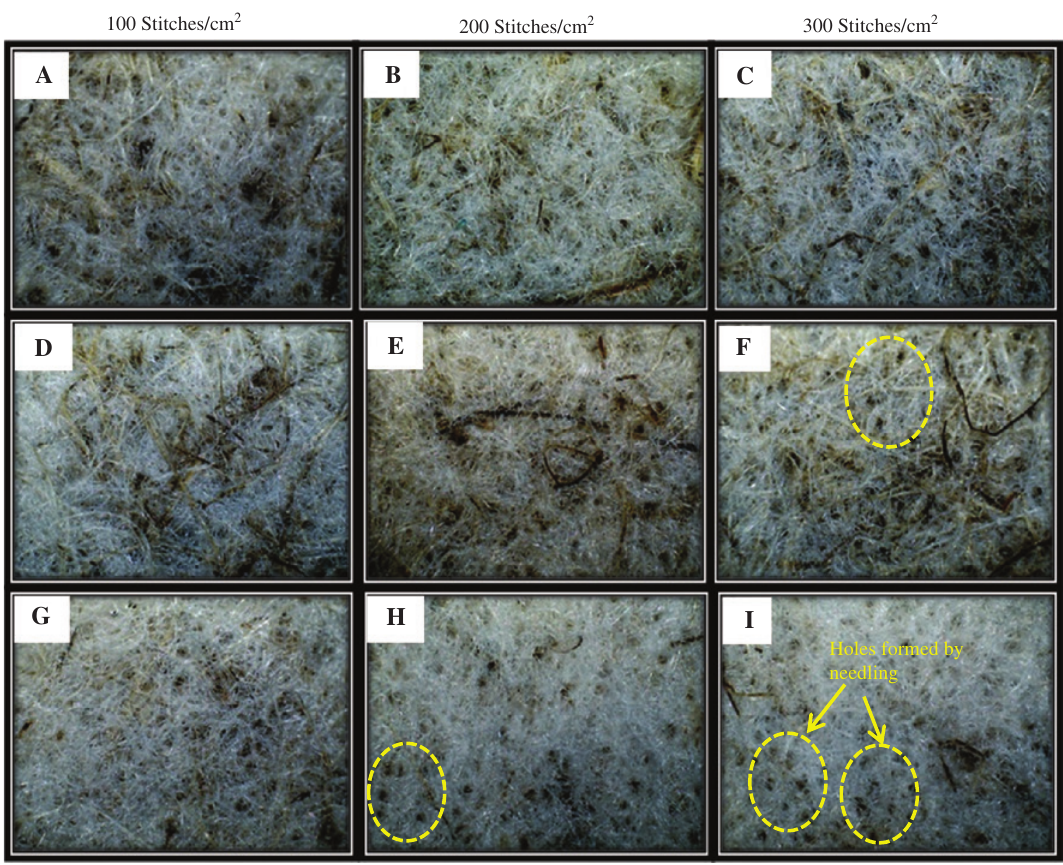
Figure 6: Optical microscope images of the nonwovens mats (20 × magnification).